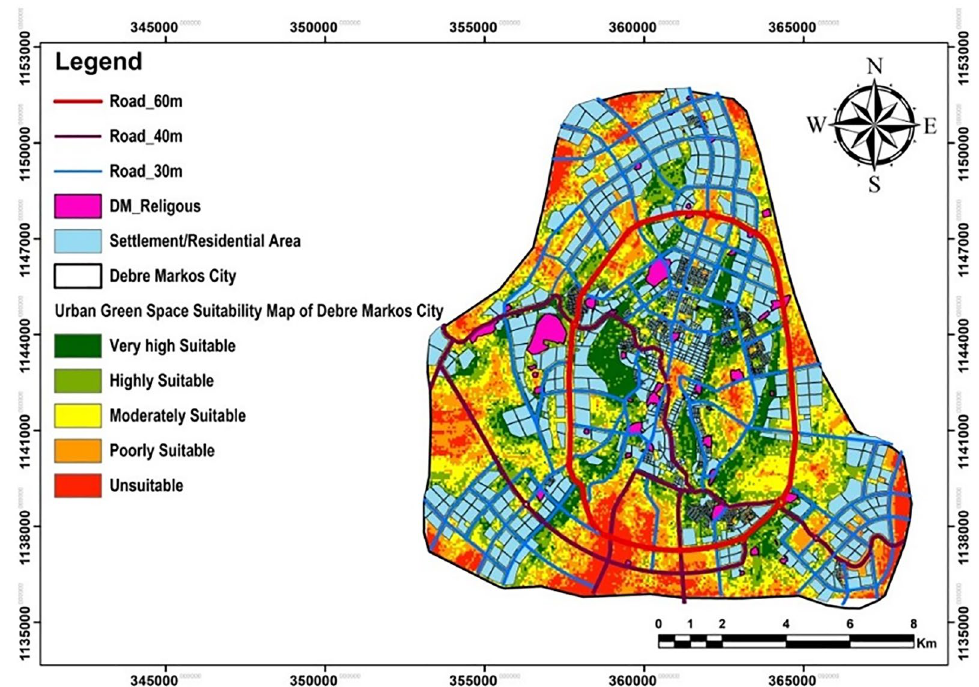
Fig. 11 Final UGS suitability sites of DMC based on main roads, religious and settlement